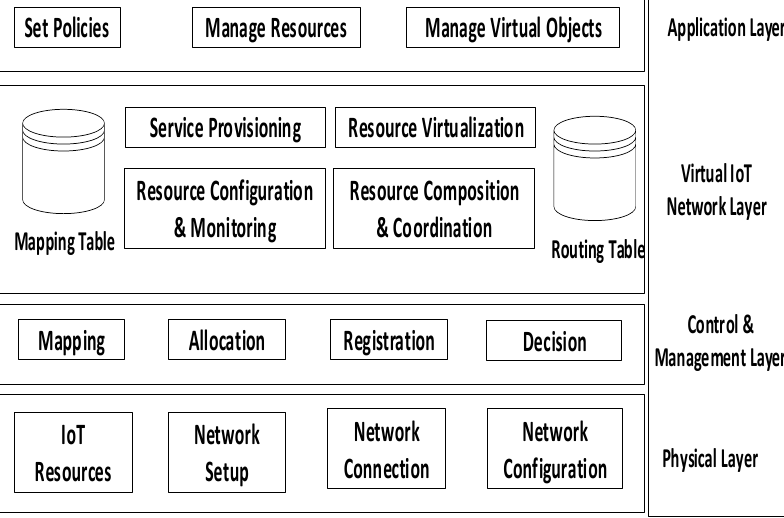
Figure 7. Administrative functions of IoT